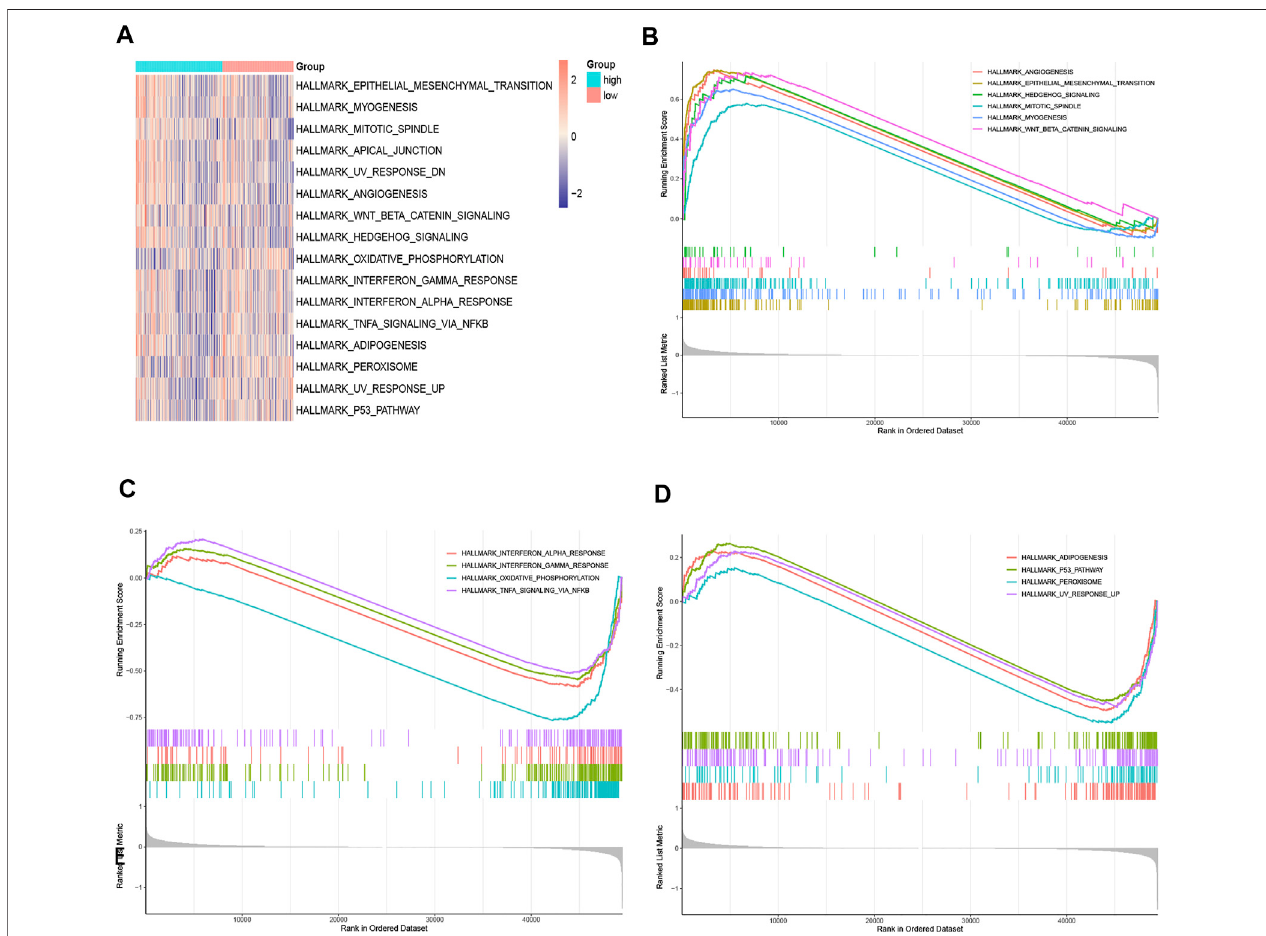
FIGURE9| Genefunctionenrichmentanalyses. (A). TheheatmapofssGSEAofthehallmarkgenesets; (B,C). Hallmarkenrichmentanalysisinthehigh-riskgroup; (D). Hallmark enrichment analysis in the low-risk group.